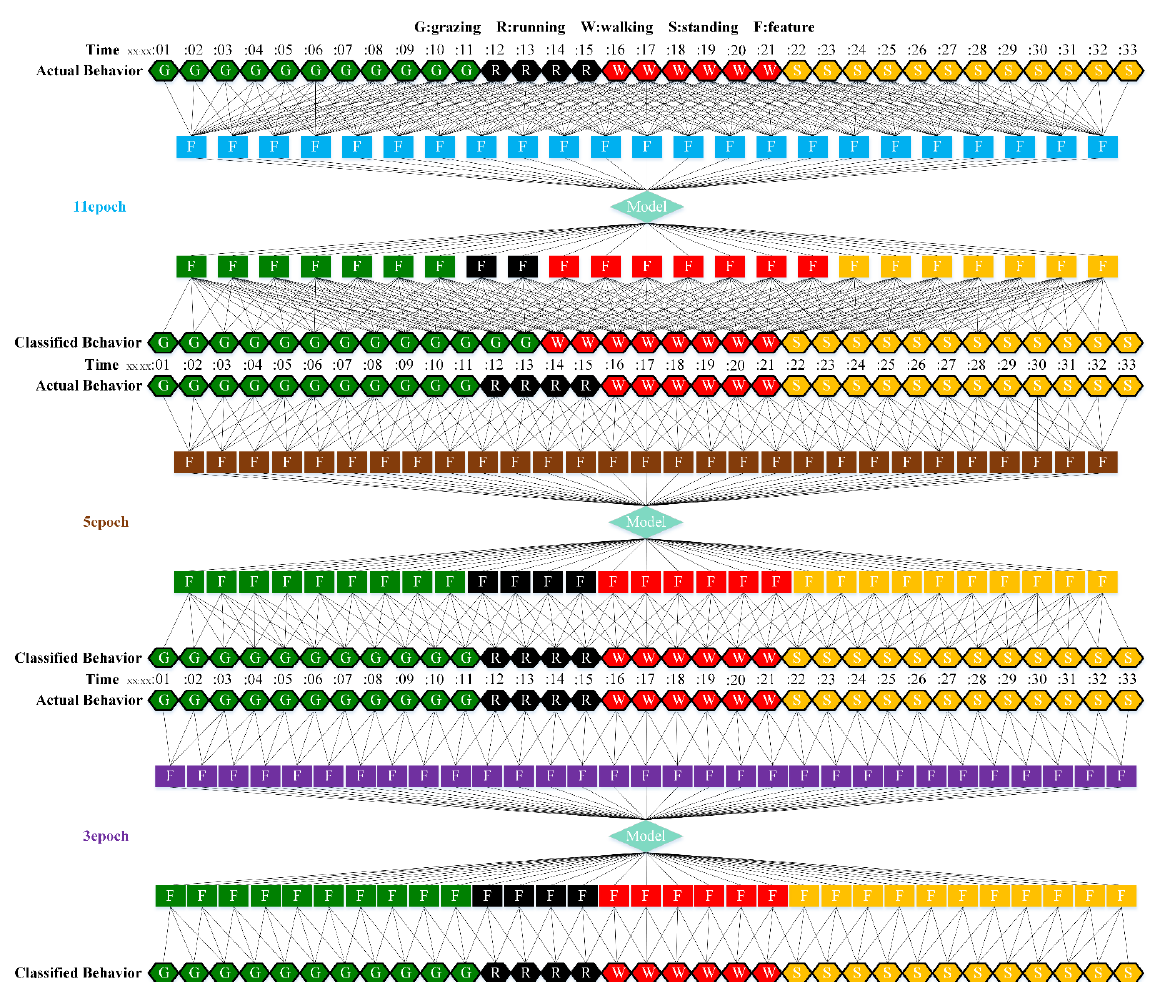
Figure 11. The process of 33 s of continuous behavior segment classification using 3, 5 and 11 s time windows with slide-moving. Assuming that the model accurately classified each behavioral feature, the classification accuracy at 3, 5 and 11 s was 100, 100 and 87.9%, respectively.